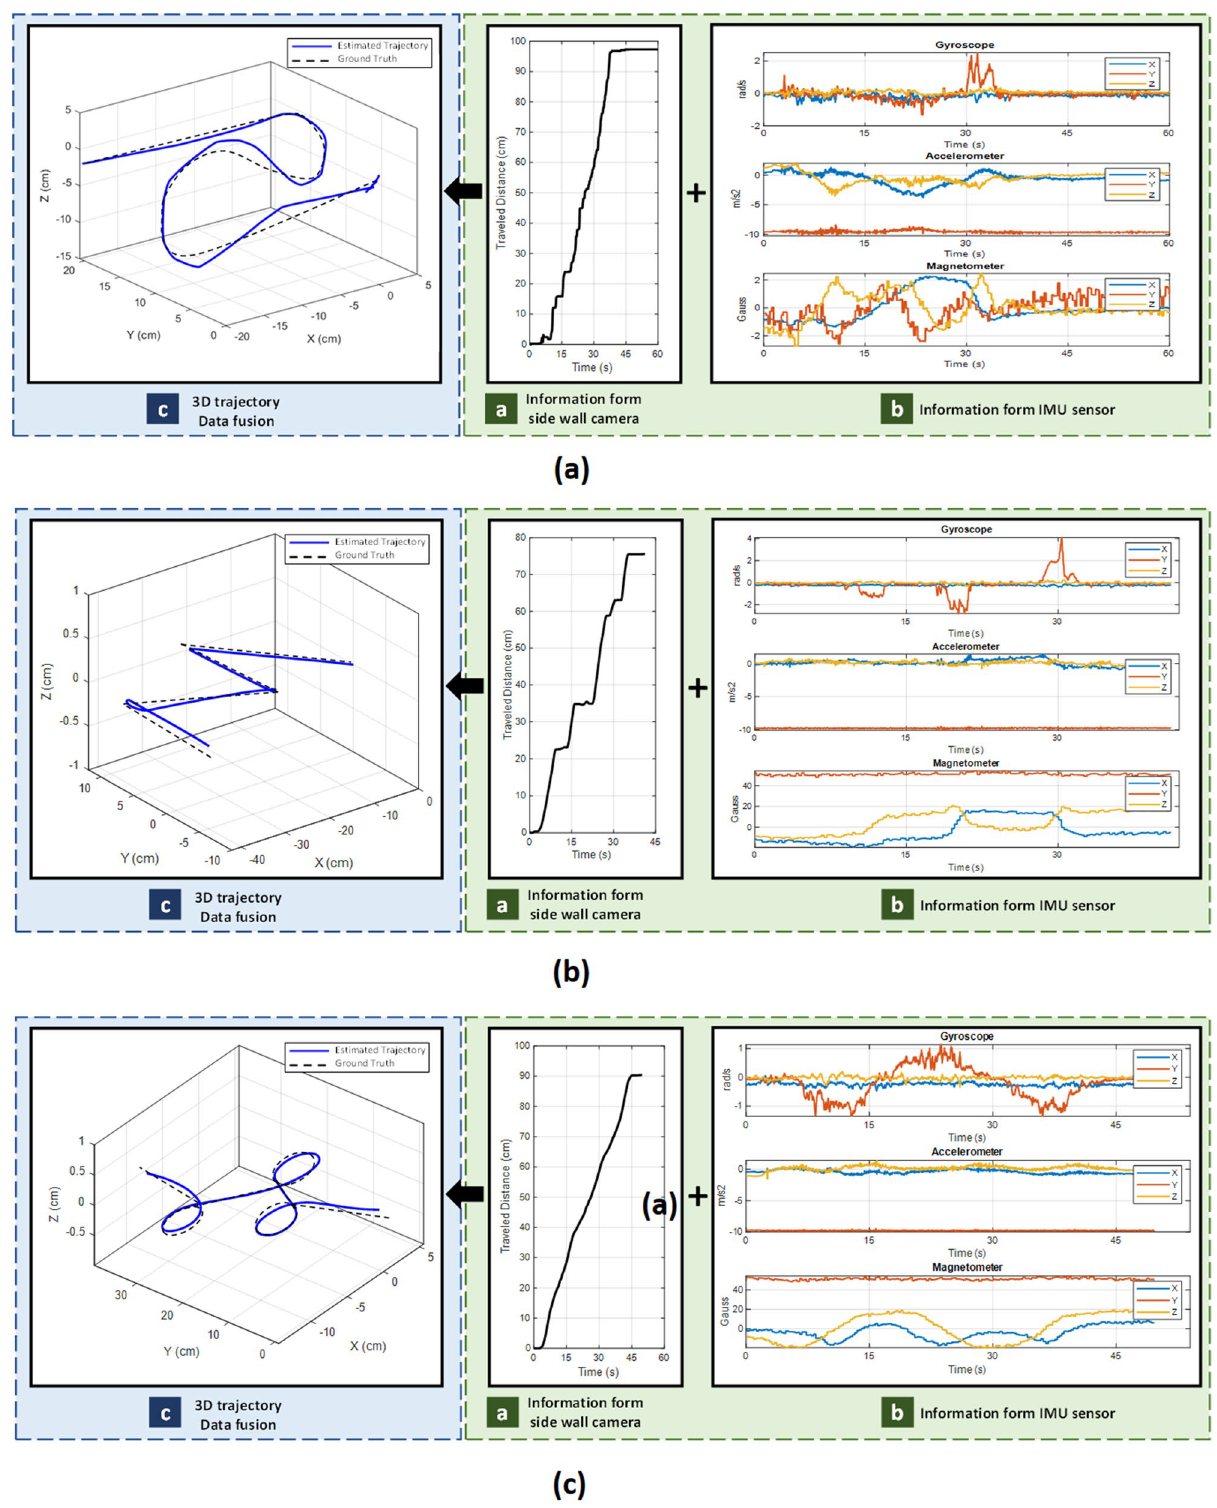
Figure 17. 3D tracking for several trajectories. In each item, traveled distance, IMU data and computed trajectory are